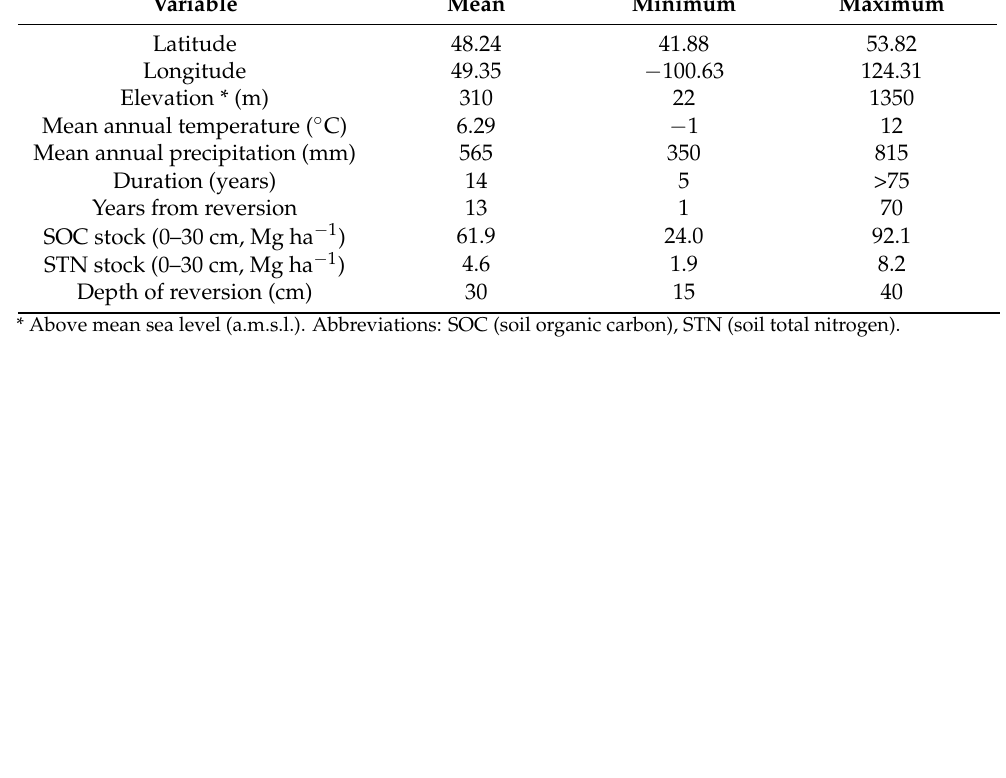
Figure 1. Location and type of perennial crops in the studies included in this meta-analysis. Table 1. Environmental and soil characteristics of studies assessing the effect of perennial crops reversion.